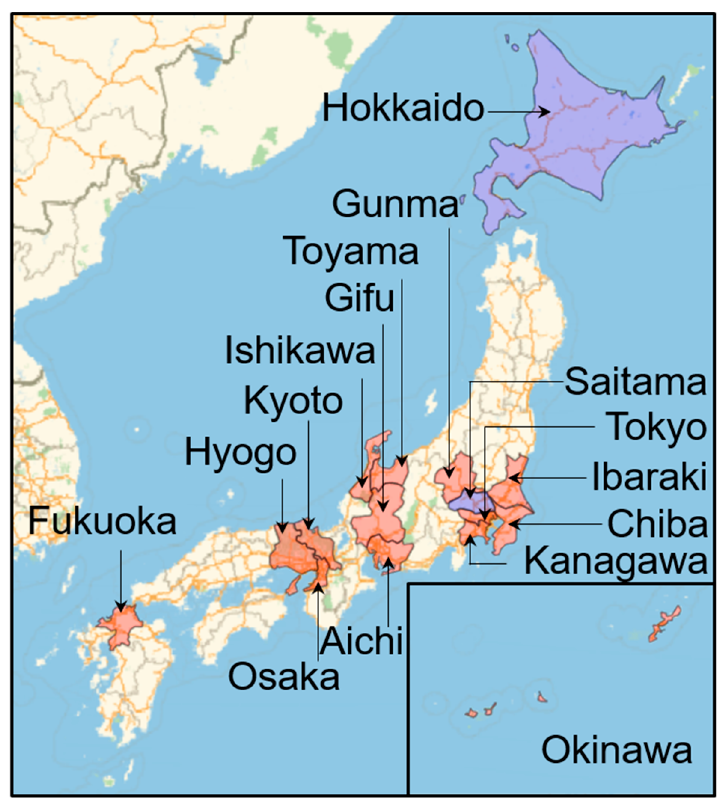
Figure 1. Map of Japan with prefectures included (excluded) in this study highlighted with red (blue) Figure 1. color.